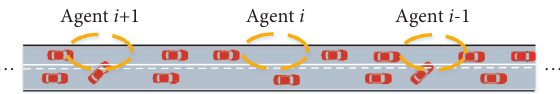
Figure 2: Neighboring agents with mutual